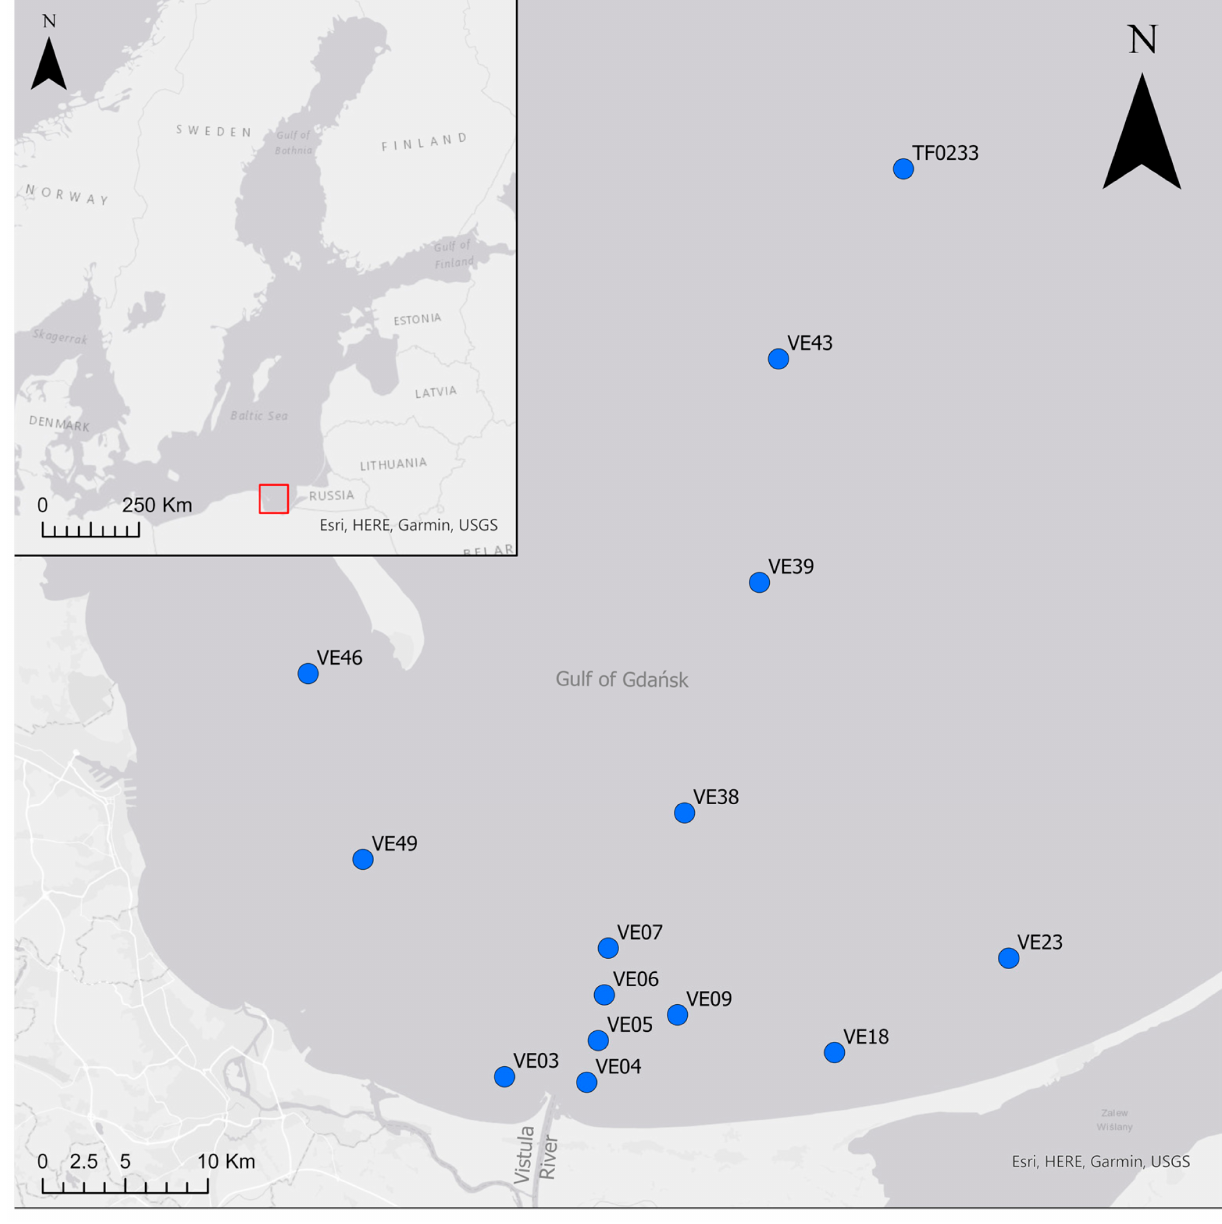
Figure 1. Study area with sampling sites. The red rectangle indicates the location of the study area on a map of the Baltic